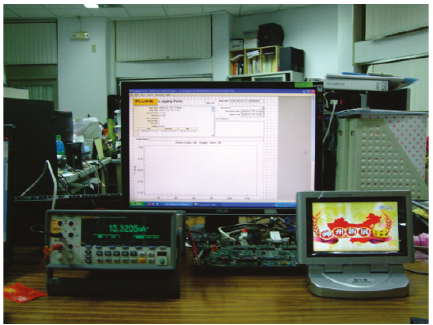
Figure 13: Experimental Environment.